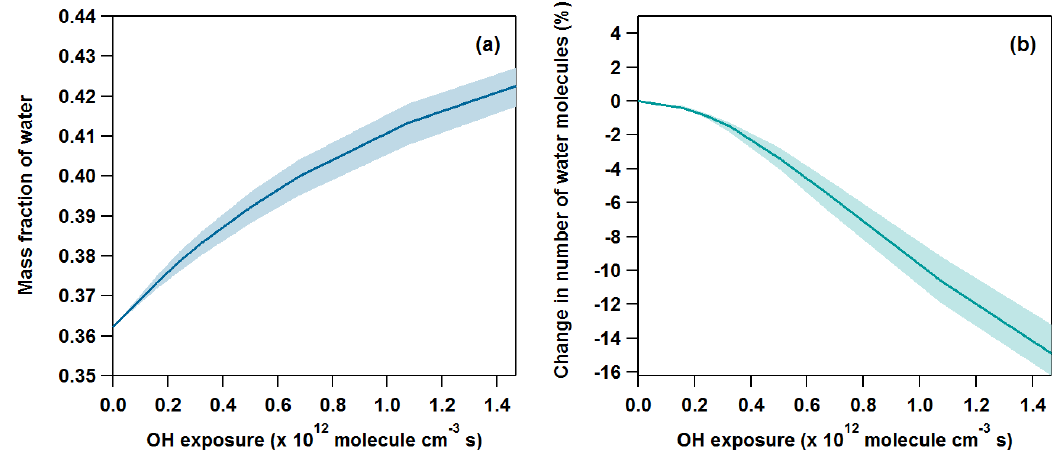
Figure 7. Simulated evolution of aerosol water content in terms of (a) water mass fraction and (b) the percentage change in number of water molecules during heterogeneous OH oxidation of aqueous methylsuccinic acid droplet. The shaded region shows the error of the effective OH uptake coefficient ( γ eff ) measurement in the model simulation.